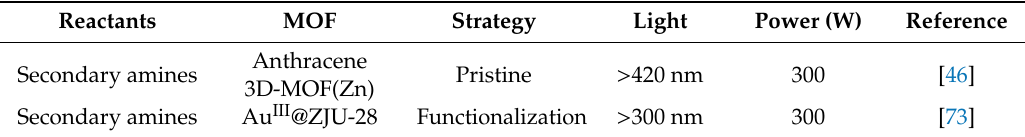
Table 5. Photooxidation reactions of secondary amines mediated by MOFs.